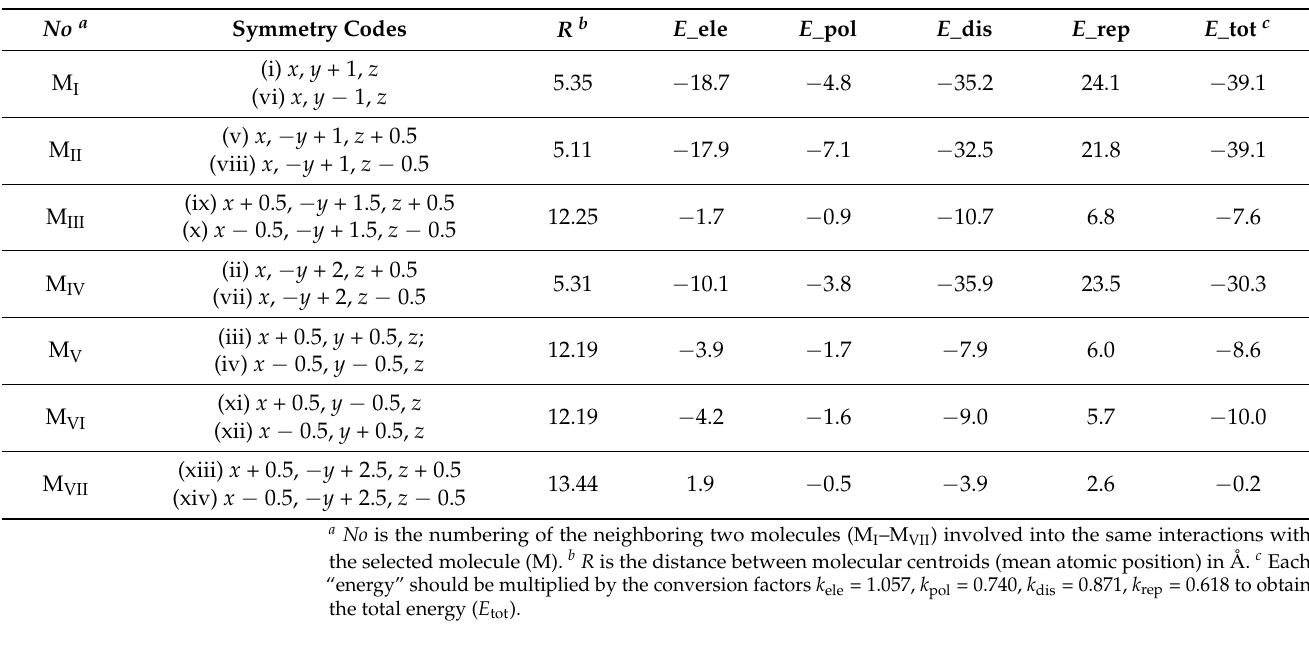
Table 3. The intermolecular interaction energies (kJ/mol) in crystal structure of 4 .